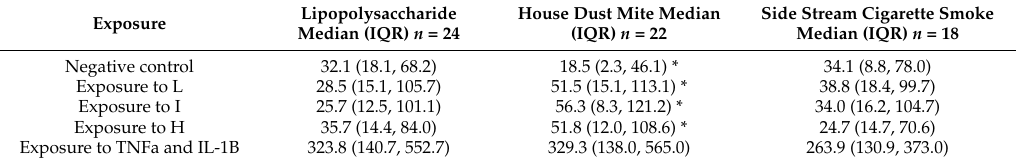
Table 2. Median and interquartile range (IQR) concentrations of interleukin (IL)-8 in supernatants from bronchial airway epithelial cell culture after exposure to lipopolysaccharide (L = lowest concentration = 1 µ g/mL, I = intermediate concentration = 10 µ g/mL and H = highest concentration = 100 µ g/mL), house dust mite (L = lowest concentration = 5 µ g/mL, I = intermediate concentration = 25 µ g/mL and H = highest concentration = 50 µ g/mL) and side stream cigarette smoke (concentrations the same as for house dust mite).